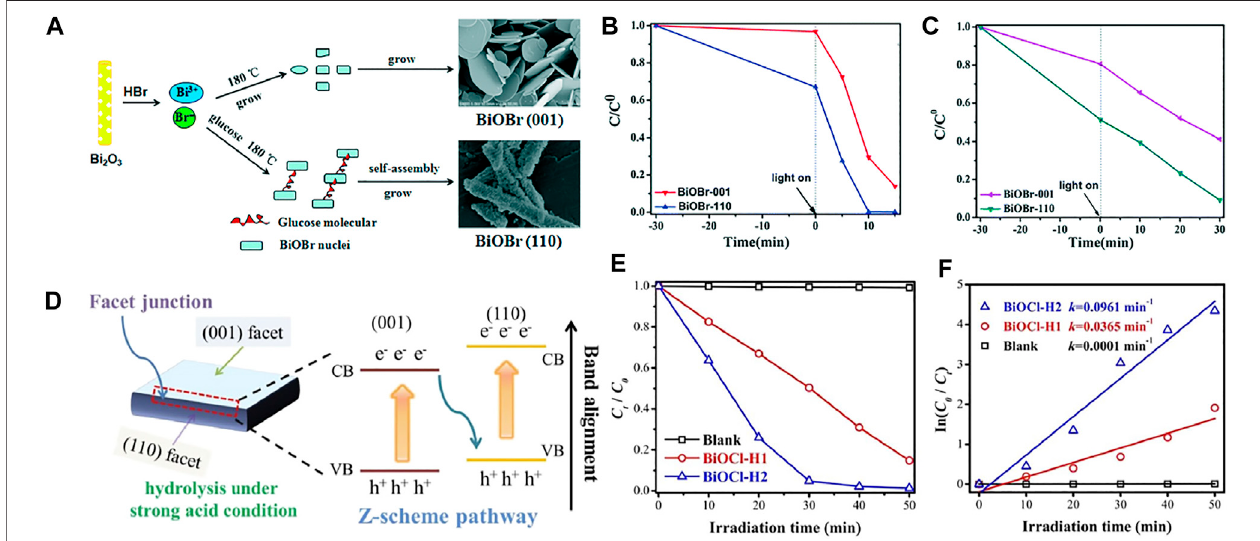
FIGURE 11 | (A) Schematic map of the proposed formation mechanism of BiOBr-110. (B) RhB and (C) MO degradation over BiOBr-110 and BiOBr-001 (Peng et al., 2017). (D) Facet junction interface charge transportation. (E) Photodegradation of RhB and (F) dynamic fi tting by using a fi rst-order model (Zhao et al., 2020) (all reproduced with